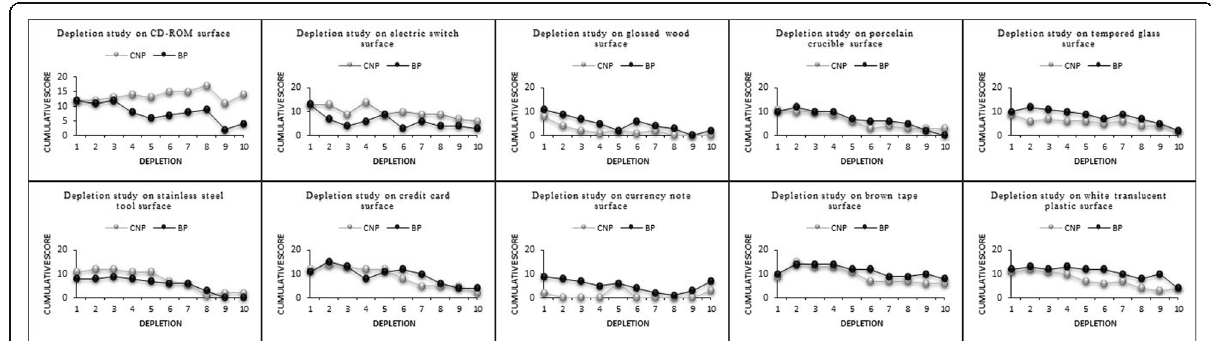
Fig. 8 Line charts that reflect fingermark scores developed with NP and BP for depletion study on non-porous and semi-porous surfaces